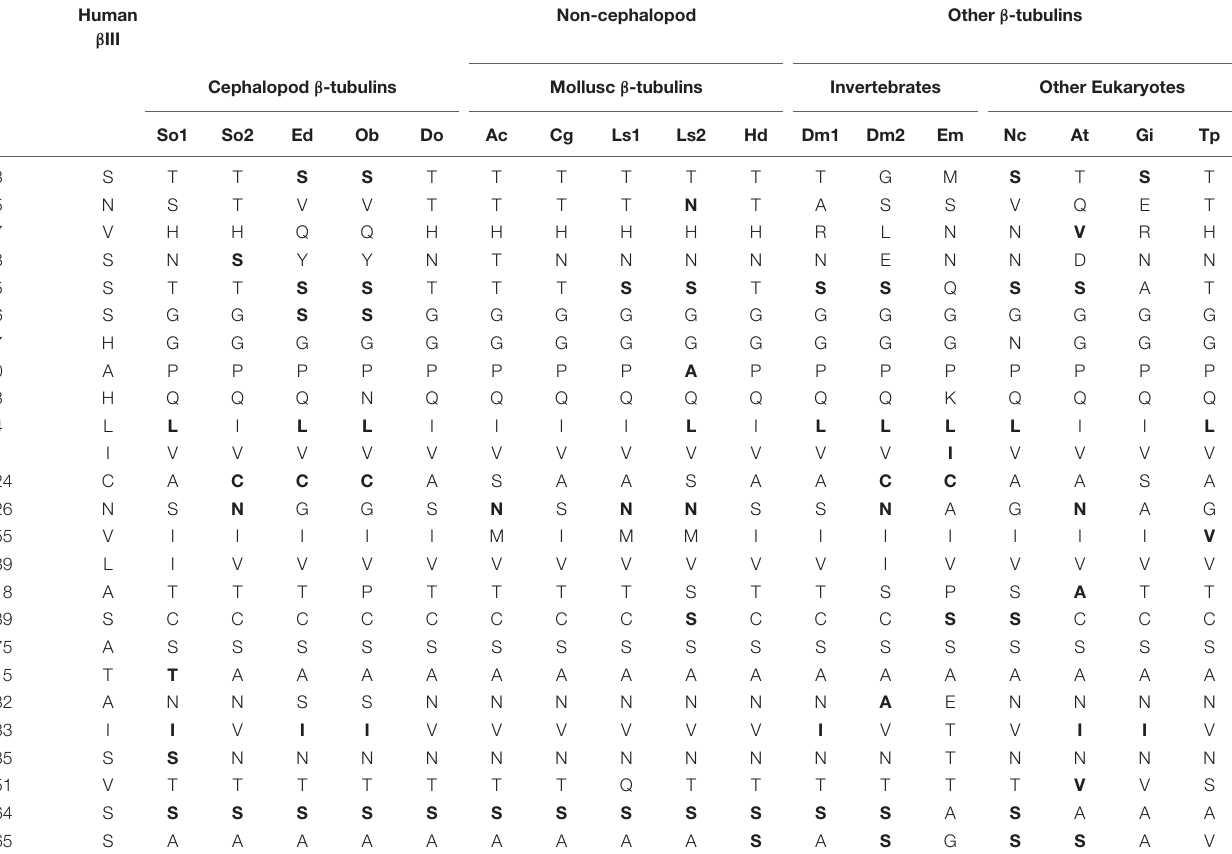
TABLE 3 | Similarities in Structure to β III and β V in Non-vertebrate β -Tubulins. # Human β III